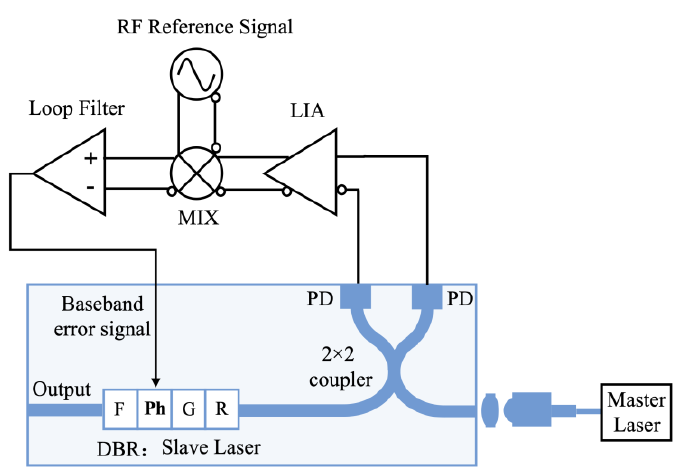
Figure 1. Schematic diagram of PIC-based heterodyne OPLL (PD: Photodetector, LIA: Limiting amplifier, MIX: Mixer, R: Rear DBR mirror, Ph: Phase, G: Gain, F: Front DBR mirror, DBR: Distributed Bragg Reflector).